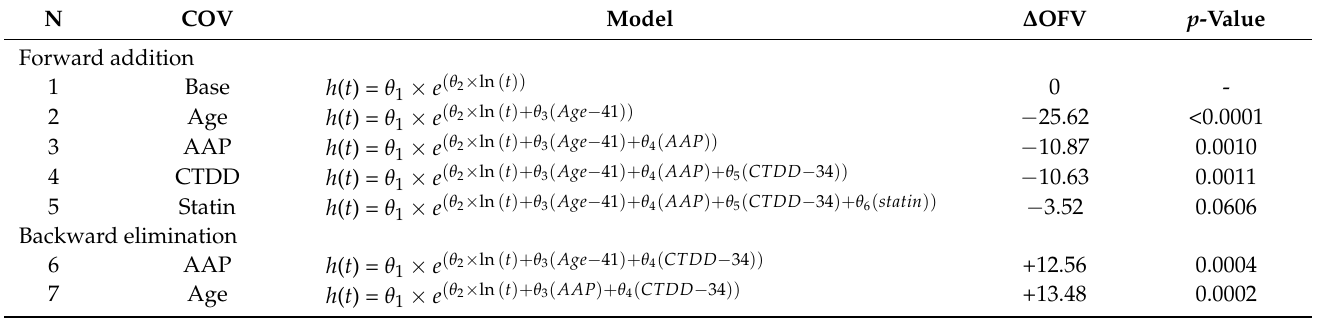
Table 4. Stepwise repeated time to improving positive symptoms model building among Malaysian patients with schizophre- nia spectrum disorders (n = 116).